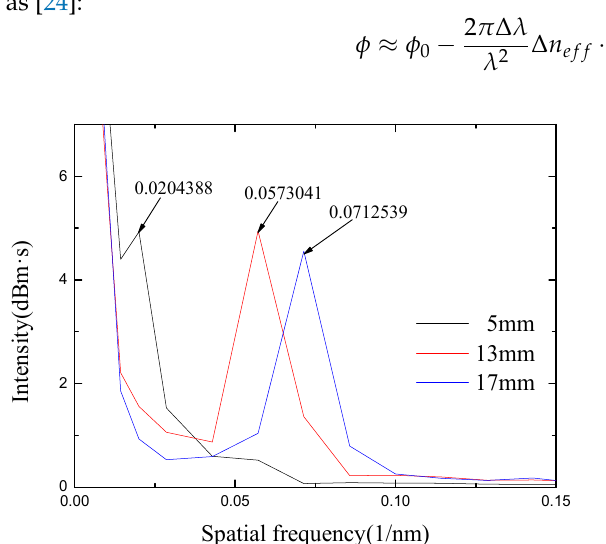
Figure 5. Spatial spectrum analysis of sensors with different